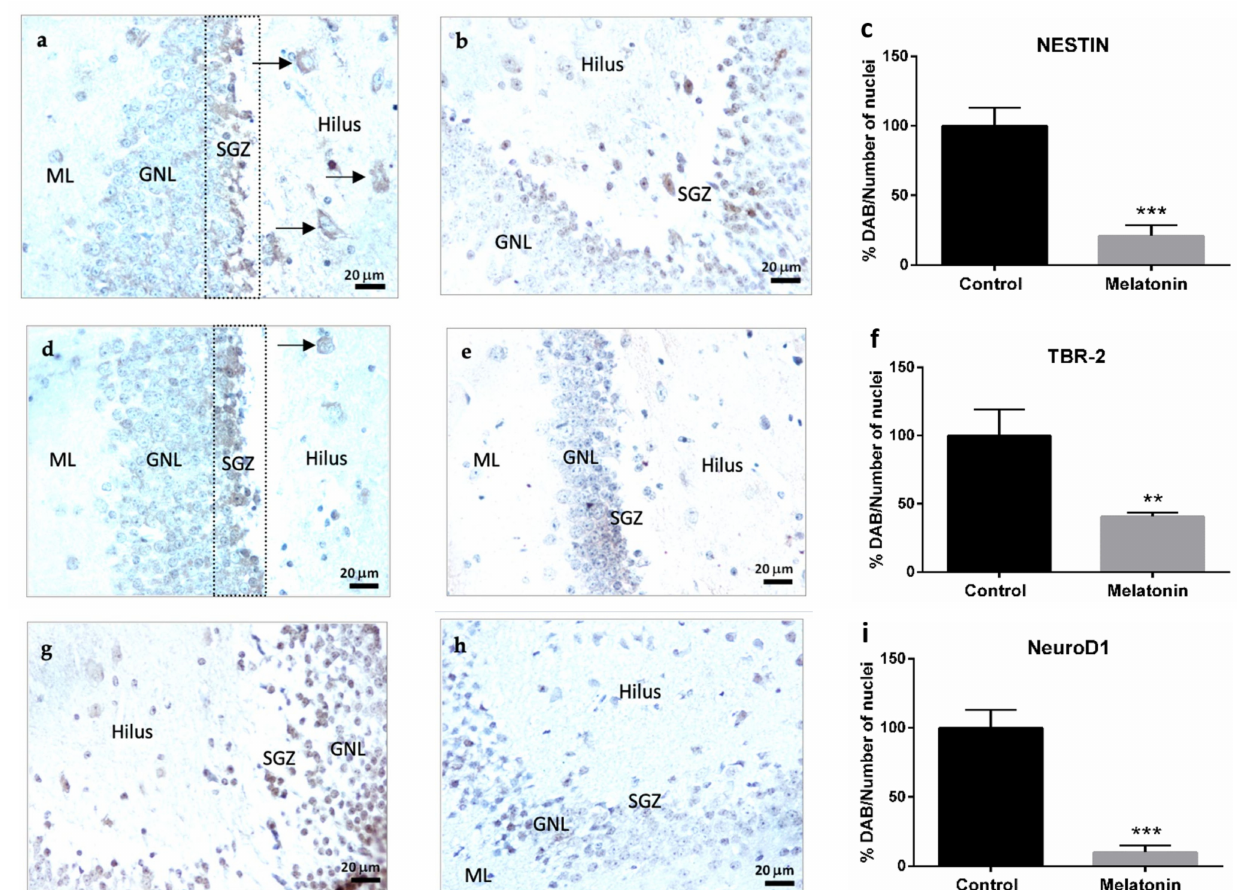
Figure 4. Markers of adult hippocampal neurogenesis in the dentate gyrus of SAMP8 control mice ( a , d , g ) and SAMP8 mice treated with melatonin ( b , e , h ). Bar charts ( c , f , i ) show quantification of the DAB signal with respect to the total number of nuclei at 400 × magnifications (in percentages with respect to the control). Data are always expressed as means ± SEM. ** p < 0.01; *** p < 0.001 vs. control. ML, the molecular layer; GNL, the granule neurons layer; SGZ, the subgranular zone. Statistical analysis was always performed in 10 images obtained from each SAMP8 control mice ( n = 4) and SAMP8 mice treated with melatonin ( n =